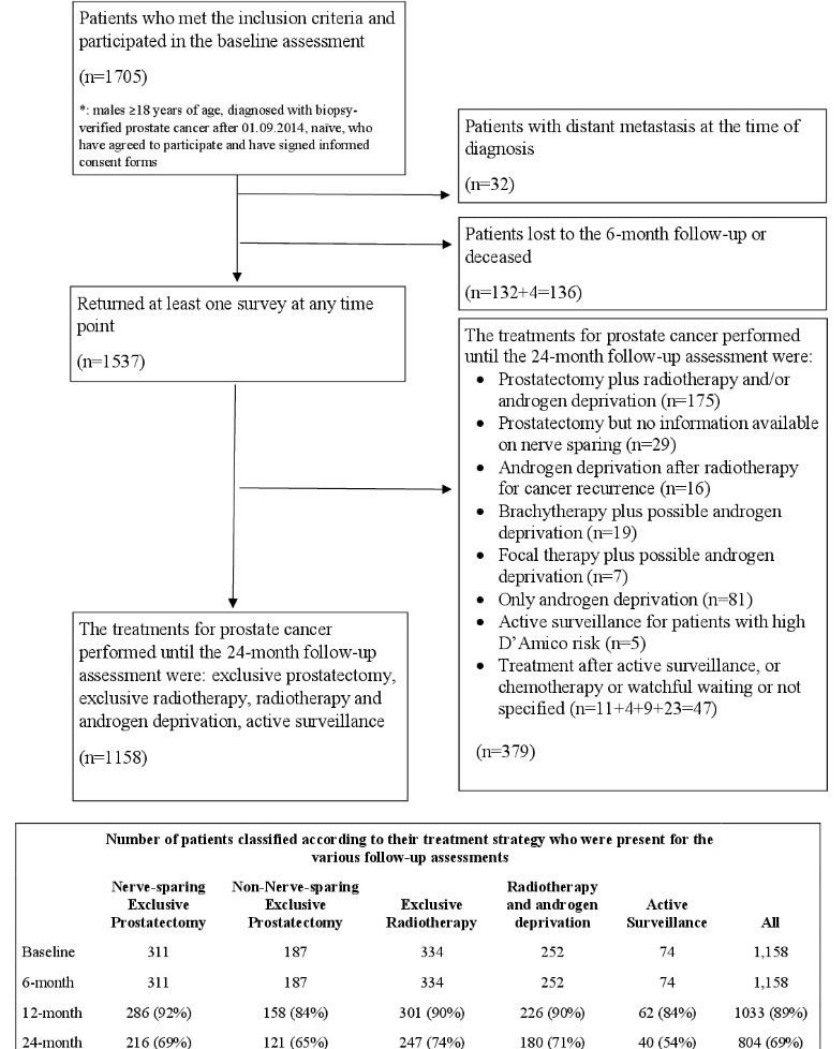
Figure 1. Flow Diagram of the Pros-IT patients.